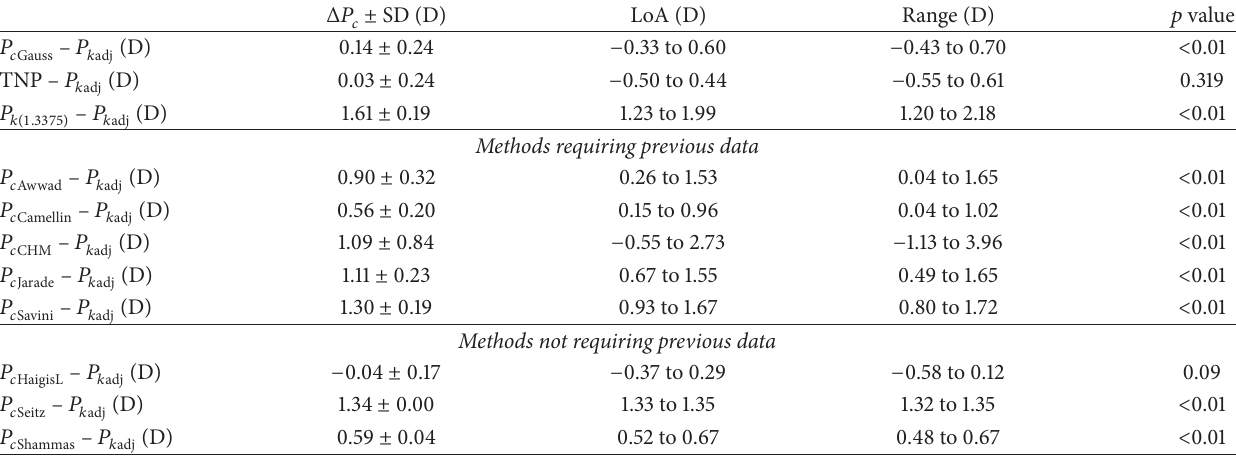
and the corneal power obtained with other methods. adj